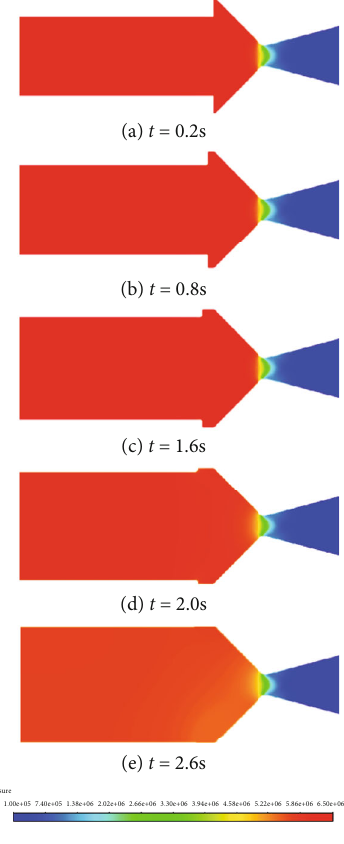
Figure 7: Contours of pressure distribution at di ff erent time points.